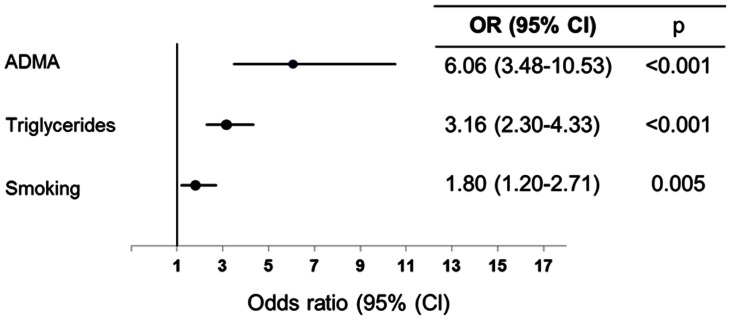
Multivariate backward logistic regression analysis with low HDL levels as the dependent variable.